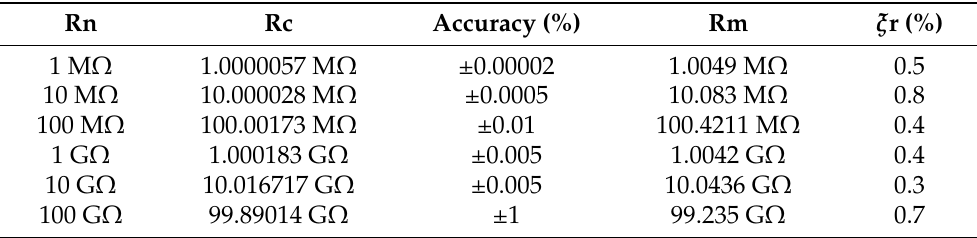
Table 1. Quantitative table: the nominal value of the measured resistance (Rn), the calibrated resistance value (Rc), the obtained value using the sensor (Rm) and the relative error ( ξ r) when comparing the results with the calibrated value Rc.